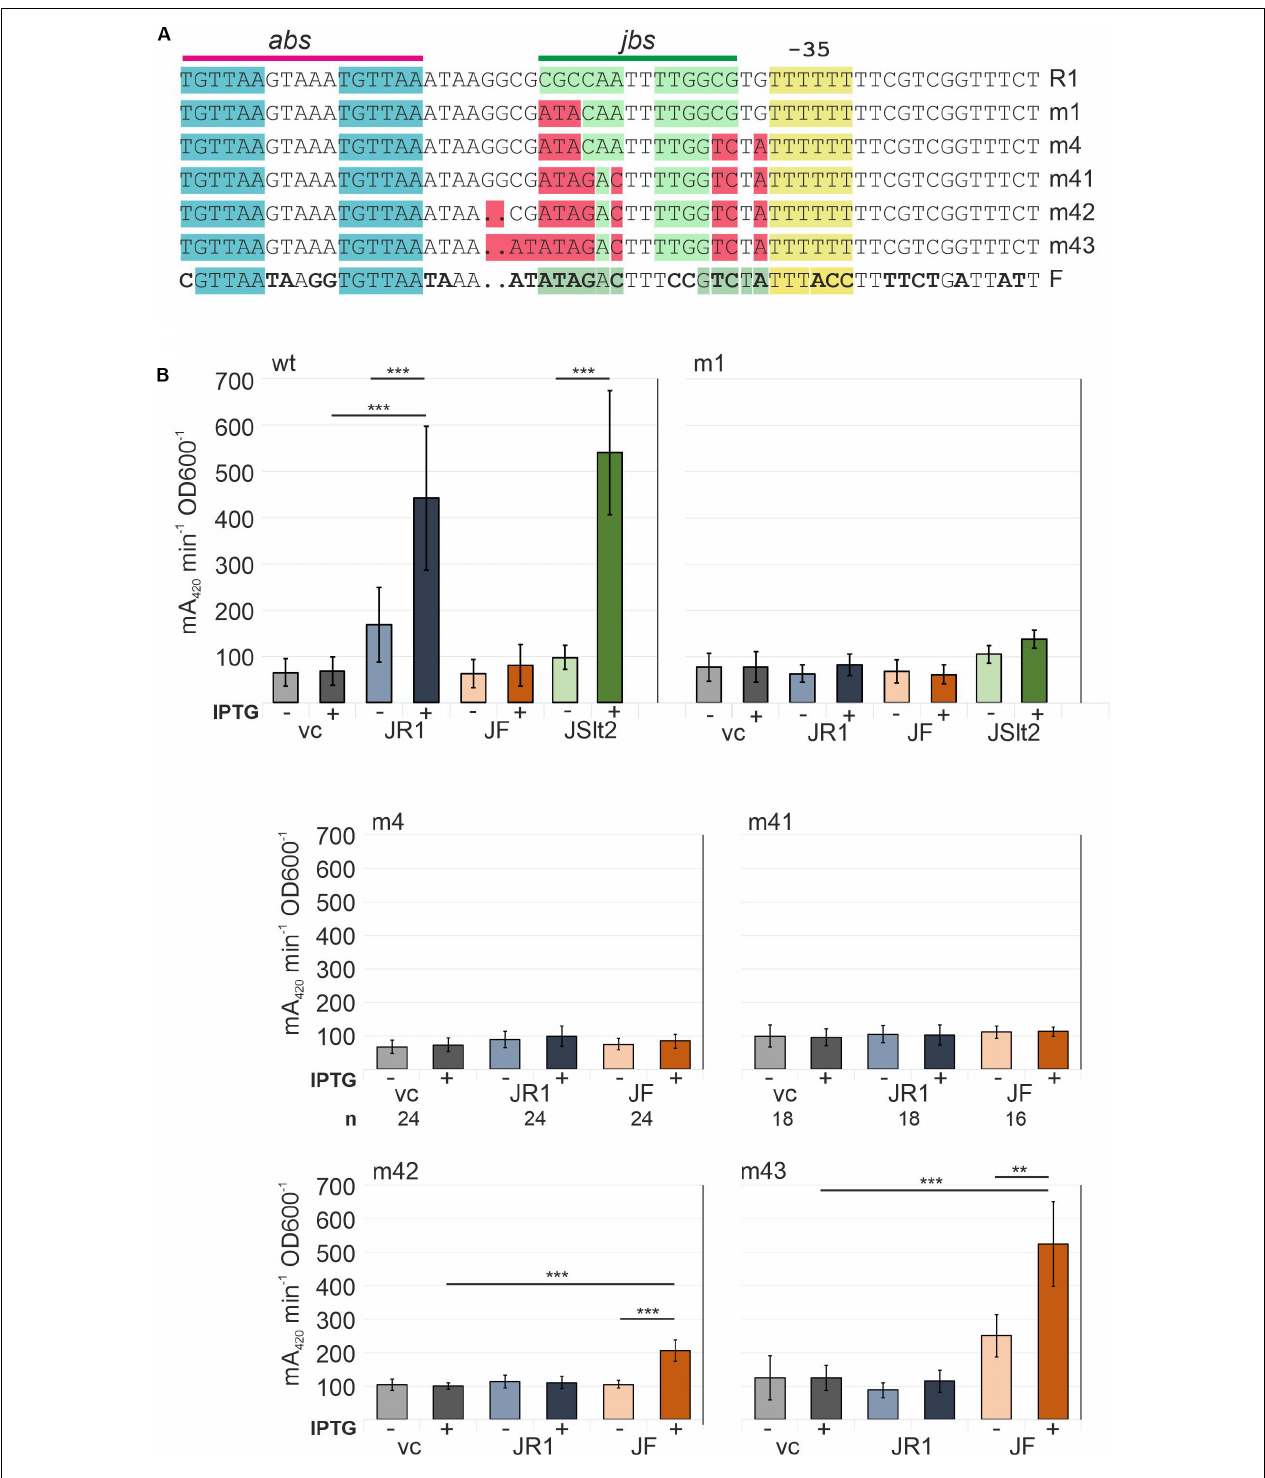
FIGURE 6 | Determination of important sequence elements in the R1P Y promoter for activation by TraJ R1 . Successively introduced mutations switch recognition specificity to TraJ F . (A) Sequences showing sequentially created site specific mutations in R1P Y . Top line shows the R1P Y wt sequence with the abs and jbs sites indicated above. Bottom line shows FP Y wt sequence with bases that differ from R1P Y in bold letters. (B) β -Galactosidase assays with bacterial cells harboring a R1P Y - lacZ promoter-test plasmid and a second compatible plasmid IPTG-inducible for expression of traJ from plasmids R1 (JR1), F (JF), or pSLT (JSlt2); vc, vector control (no traJ ). IPTG (inductor): +(added), − (not added). Mean values and standard deviations were calculated from at least three independently carried out experiments with two technical replicates for each experiment. P -values (paired t -test): ** P < 0.01; *** P < 0.001.